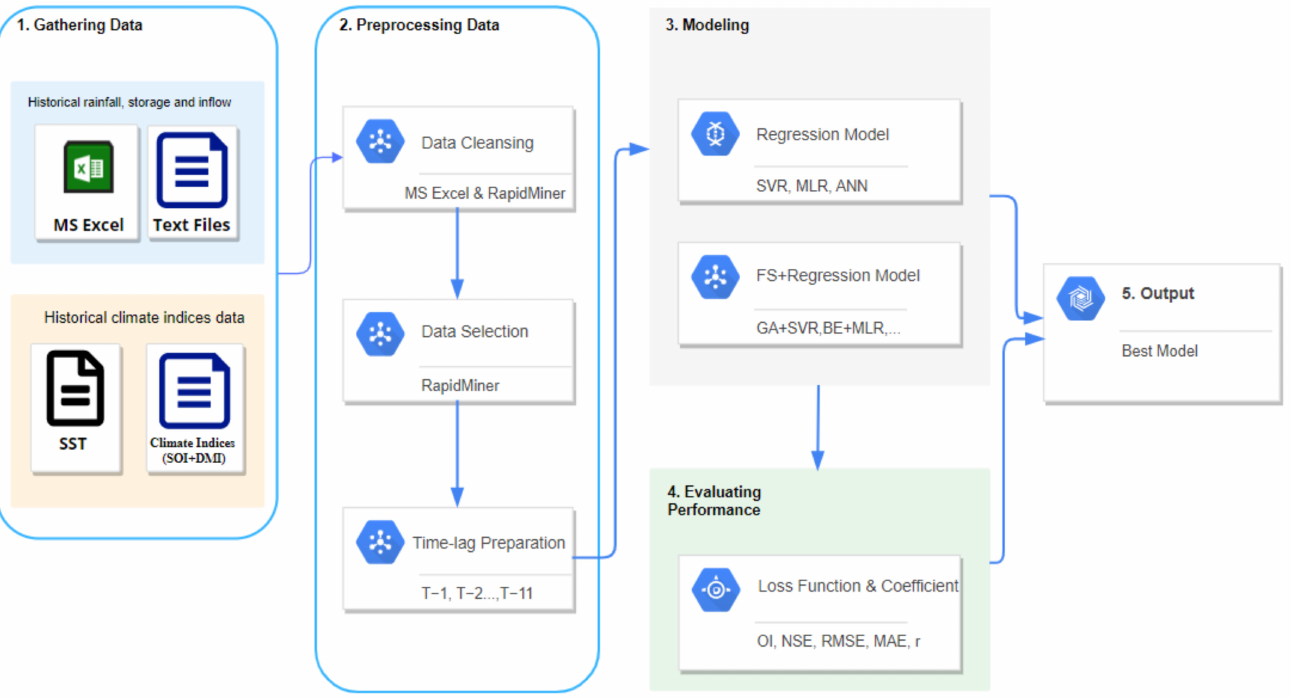
Figure 1. Overview of the research